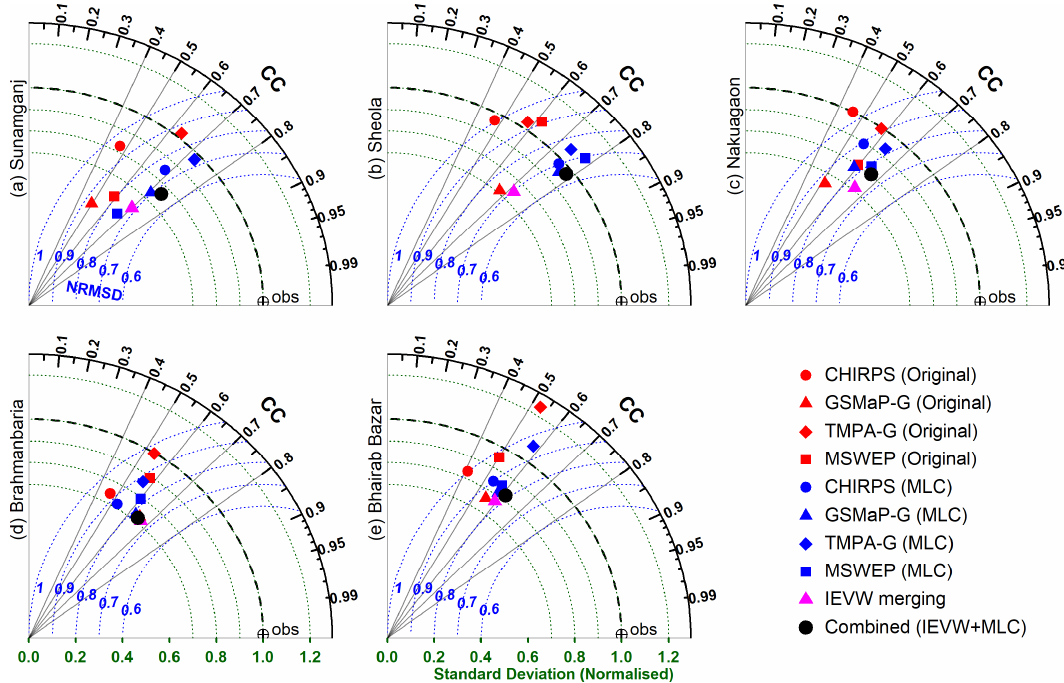
Figure 10. Taylor diagram with the statistical comparison of the original GSRPs, the MLC-corrected GSRPs, and the IEVW-based merged product of the original GSRPs (both without and with the MLC bias correction) against ground rainfall for the wet seasons of 2009–2016 at the five validation stations ( a – e ). Instructions for reading a Taylor diagram are given in Figure 8.